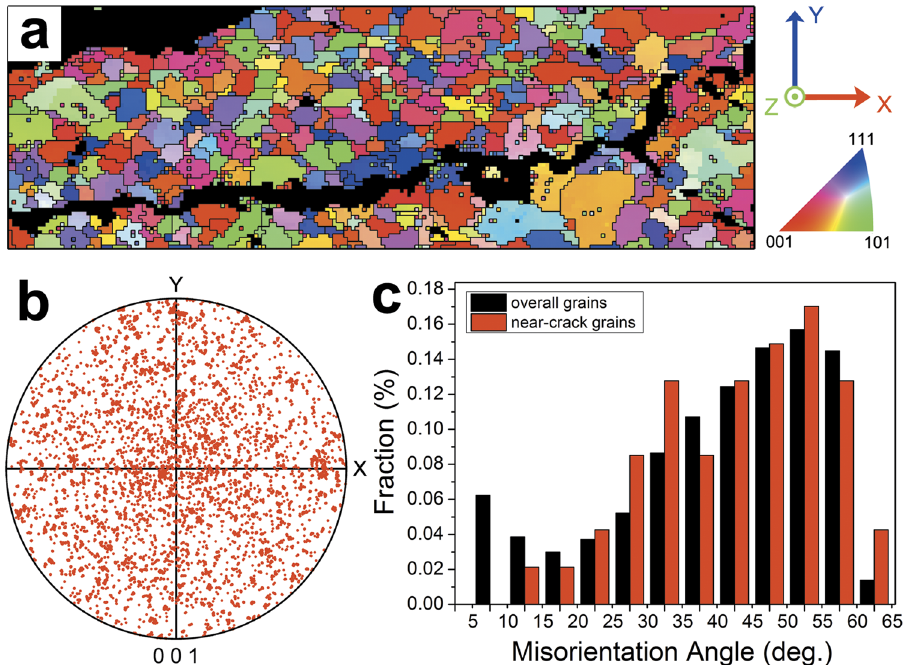
Figure 2. Crystal orientation characterization of the crack containing region. ( a ) The inverse pole figure map showing the crystal orientation along xx-axis. ( b ) The inverse pole figure showing random crystal orientation distribution in the scanned region. ( c ) Statistical distribution of GB misorientation for the overall scanned area and the grains adjacent to the crack,